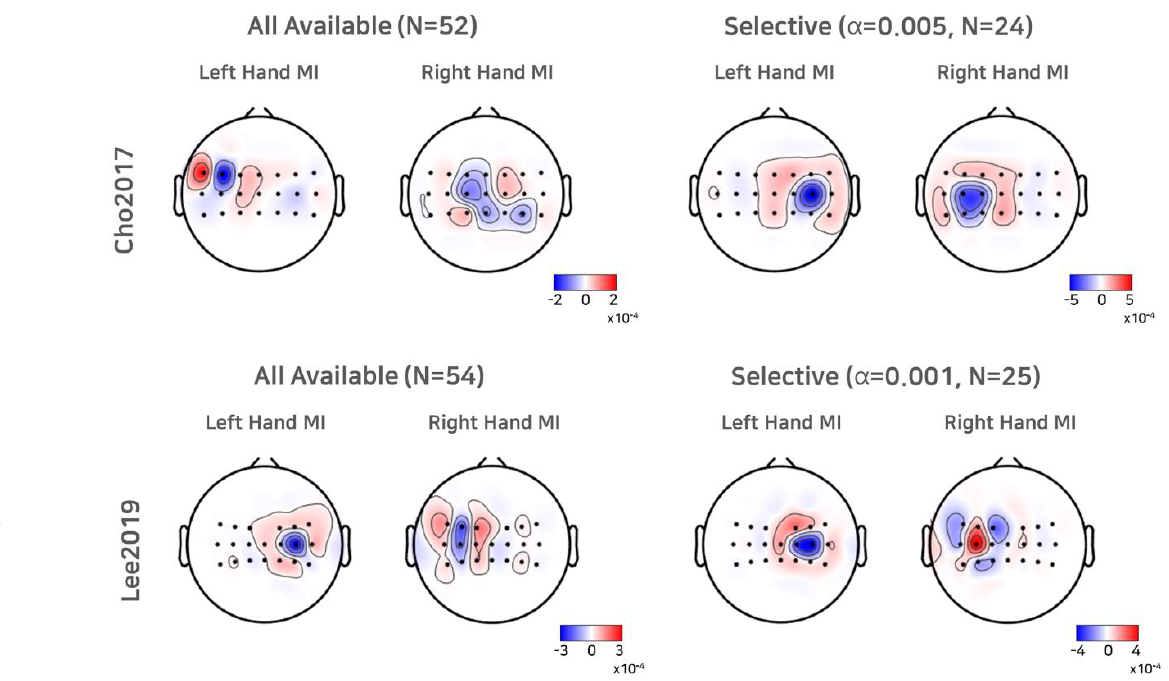
Figure 5. CSP filters created using all subjects available and selective subjects. For the Cho2017 ( a ) and Lee2019 ( b ) datasets, the topo plots represent the first and last CSP filters created using all subjects available and the selective subjects ( α = 0.005, for Cho2017 and α = 0.001 for Lee2019).